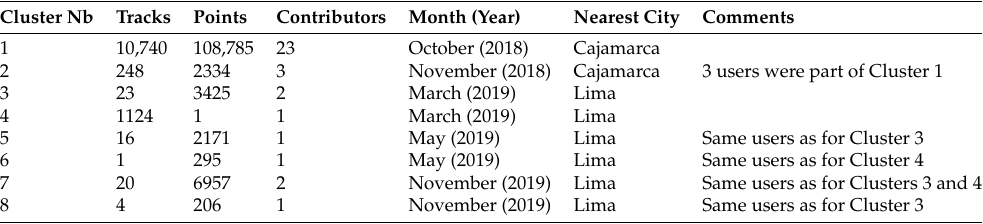
Figure 6. Representation of the 8 clusters found in Peru (the black points represent the non-clustered data), using the DBSCAN approach with Eps = 3000 m and MinPts = 200 points; represented area of approximately 750 km × 1200 km. Table 3. DBSCAN approach for the data collected in Peru: 8 clusters are found (see also Figure 6). Cluster Nb Tracks